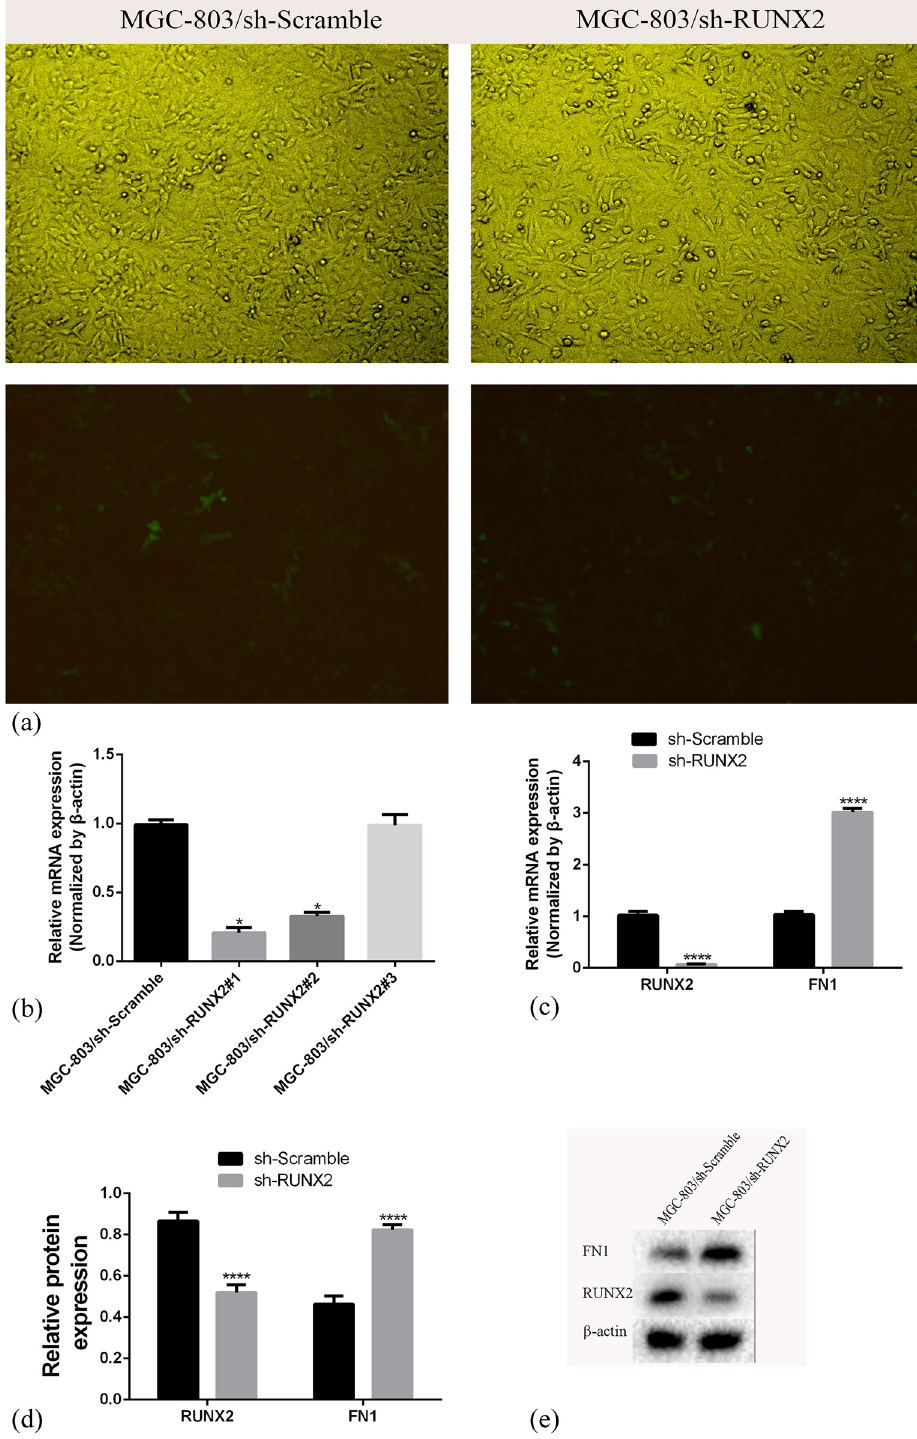
Figure 3: MGC - 803 cells were transfected with lentivirus - shRUNX2 ( MGC - 803/sh - RUNX2 ) and lentivirus - Scramble ( MGC - 803/sh - NC ) . ( a ) Representative graphs of MGC - 803 cells infected with the indicated lentivirus. ( b ) Transfection e ffi cacy of the three lentivirus - shRUNX2 vectors. ( c ) RUNX2 and FN1 mRNA levels in the two groups after stable transfection. ( d ) and ( e ) RUNX2 protein expression levels after stable transfection ( **** p < 0.0001 )